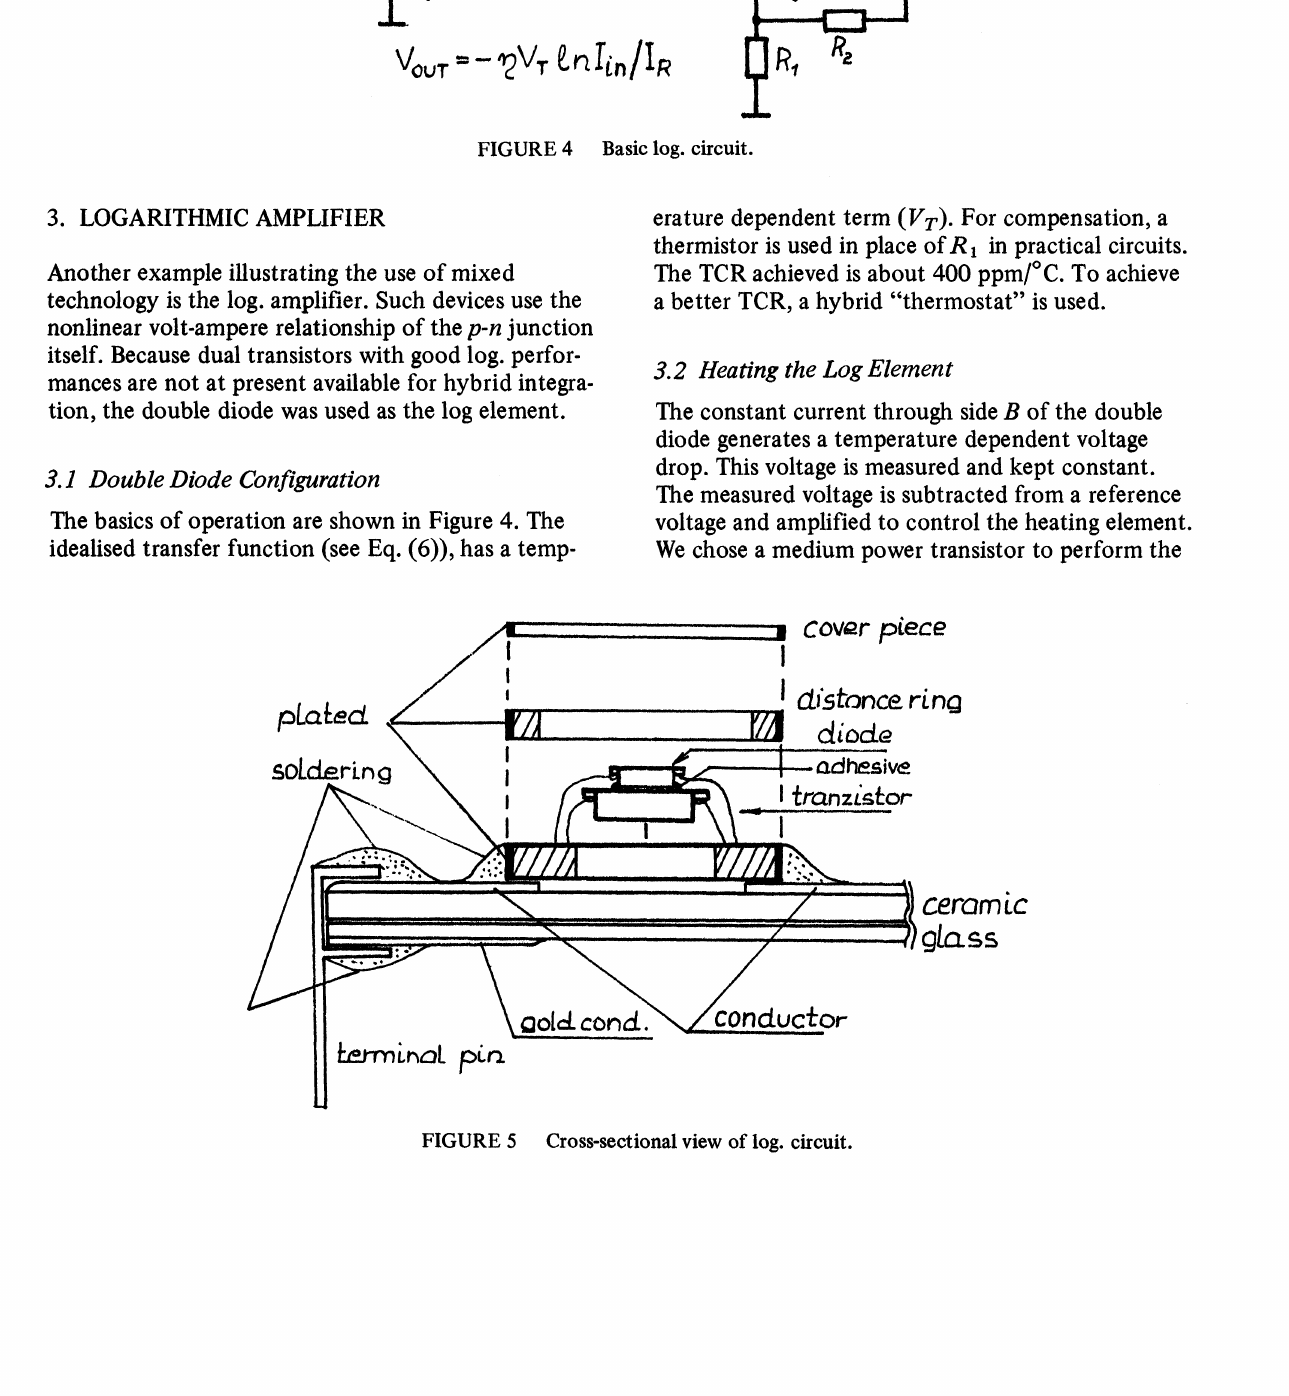
FIGURE 4 Basic log. circuit.